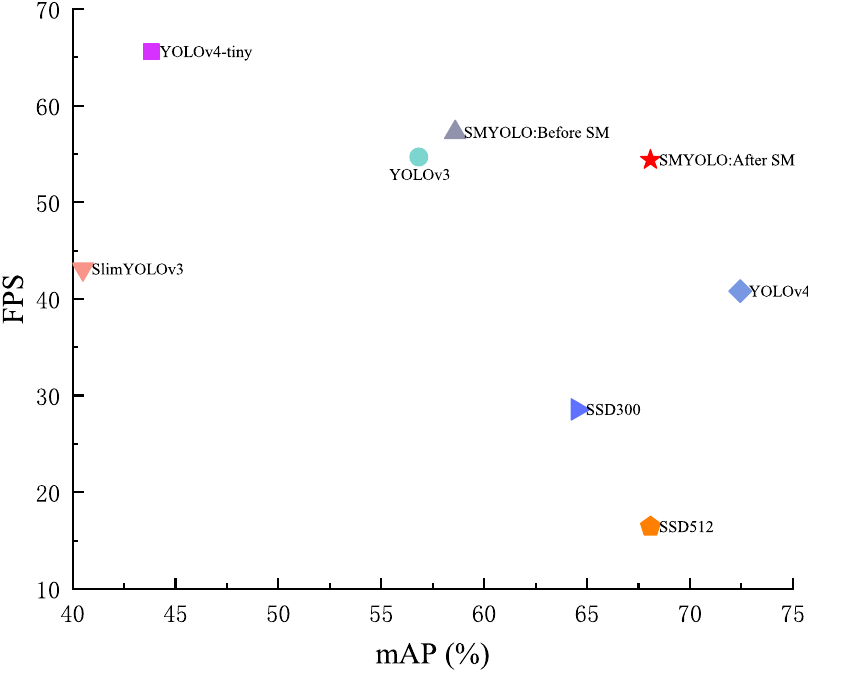
Figure 9. FPS and mAP comparison with mainstream target detection algorithms. Table 3. Comparison between the proposed method and advanced detection